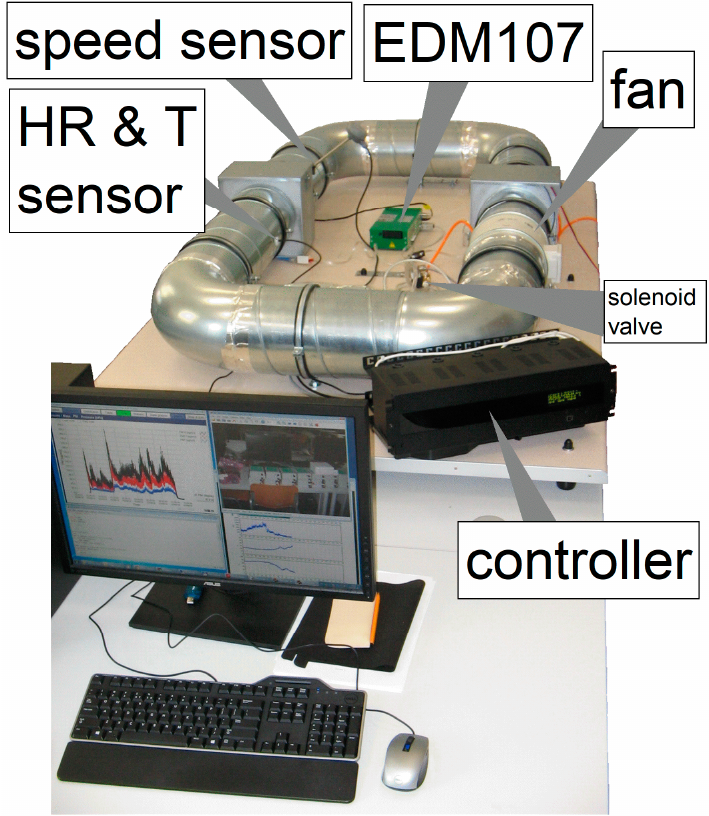
Figure 1. View of the calibration system.